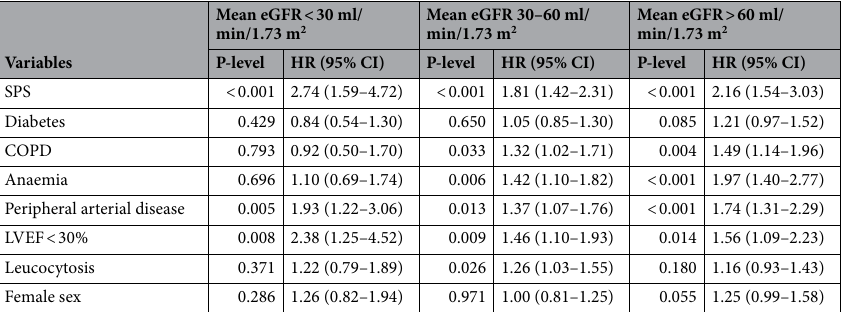
Table 3. Cox multivariable analysis of risk factors for mortality in different eGFR strata; < 30 ml/min/1.73 m 2 , 30–60 ml/min/1.73 m 2 and > 60 ml/min/1.73 m 2 . COPD chronic obstructive pulmonary disease,